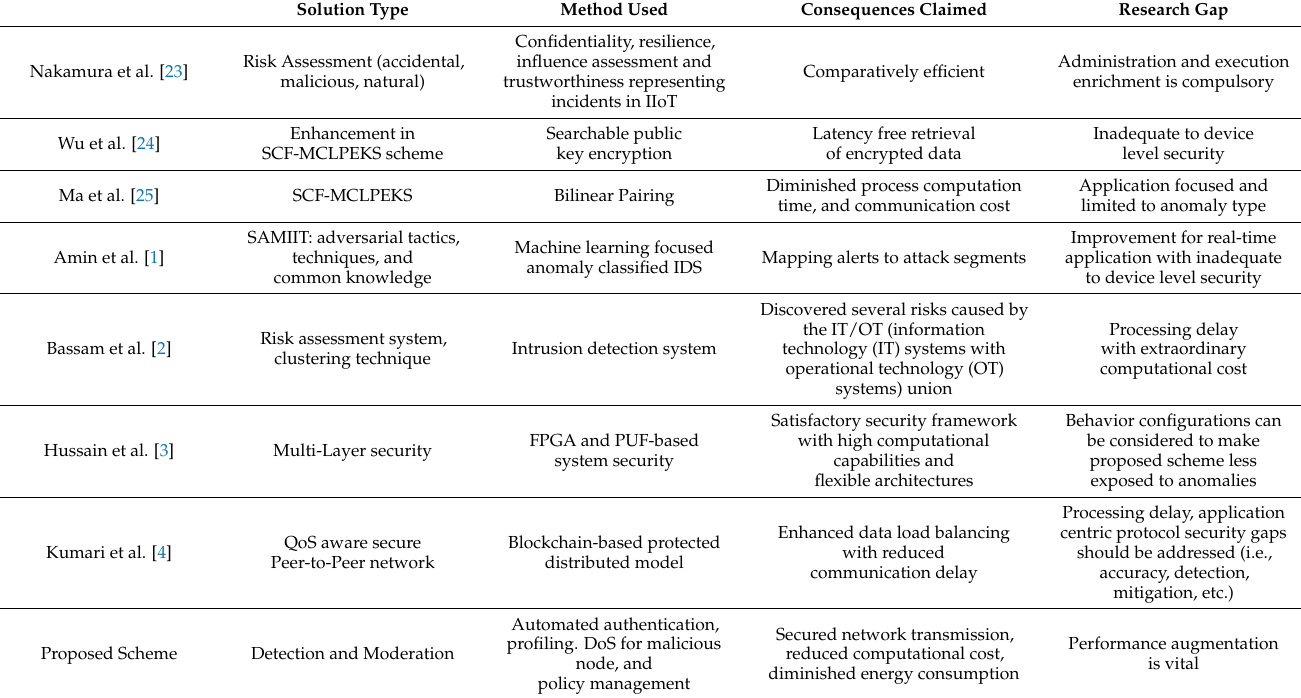
Figure 7. Confusion Matrix Chart with information generated and fetched from five initial datasets. ( a ) Confusion Matrix Outcome. ( b ) Automated data-driven Confusion Matrix Calculator. Table 6 provides a comparative analysis of schemes that were discussed and evalu- ated in contrast with the proposed scheme with respect to solution time, used method, and demonstrated outcome and research gaps. Table 6. Comparative